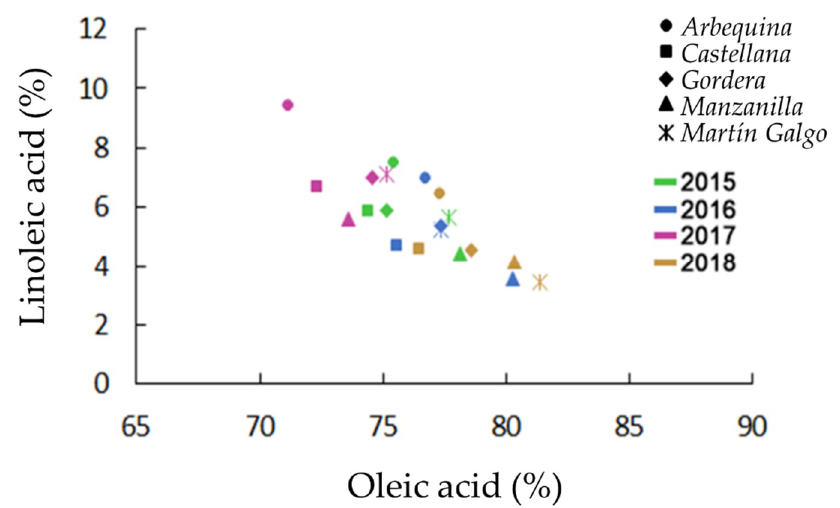
Figure 4. Oleic and linoleic acid content of the monovarietal oils produced with the varieties of olives grown in the Aceite de la Alcarria PDO across four consecutive olive crop seasons. Mean values of the samples elaborated in each season.